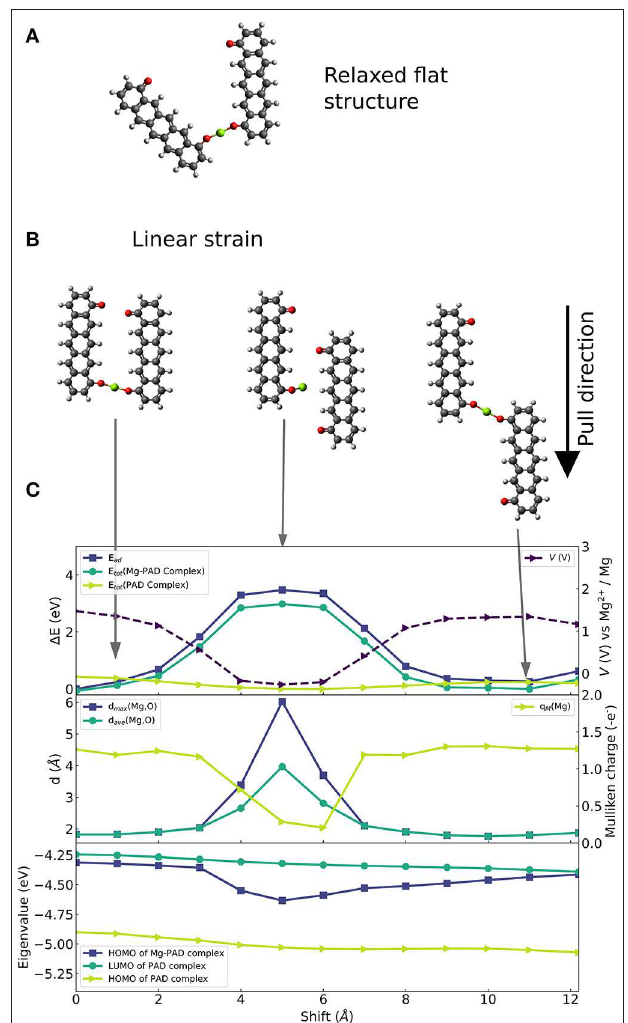
FIGURE 2 | Constrainted calculation on 6-membered ring-fused PAD structure with two carbonyl groups per molecule. (A) Optimized geometry of the planar system. (B) Selection of strained configurations in which one of the PAD molecules is parallelly shifted with respect to the other molecule: (left) Initial structure with parallel alignment of the PAD molecules shown in (A) , (middle) configuration with the highest strain energy equivalent, (right) configuration with final shift with a similar O-Mg-O bond as in initial structure. (C) Overview of electronic changes and properties during the shift: (top) Change of reaction energy (left axis) of Mg insertion (dark blue, square), change of energy of the complexes with (green, circle) and without Mg atom (light green, triangle), as well as computed voltage during parallel shift (right axis, dashed curve). (Middle) Maximal (blue, squares) and average distance (green, circles) between nearest two O atoms and the Mg atom; Mulliken charge on the Mg atom (light green curve) is given on the right axes. (Bottom) Eigenvalues of HOMO before and after Mg attachment (light green and blue, respectively) and eigenvalues of LUMO before Mg attachment (green).